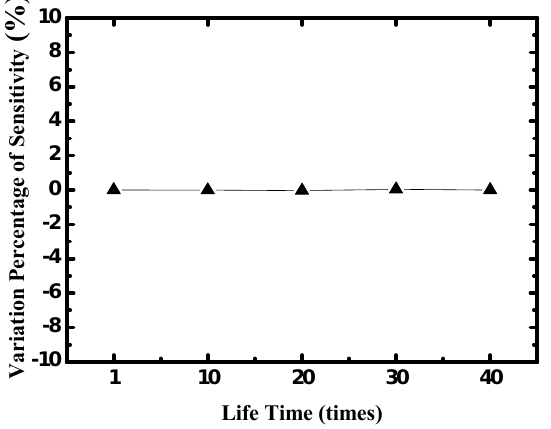
Figure 8. The life time of the uric acid biosensors on TNTs